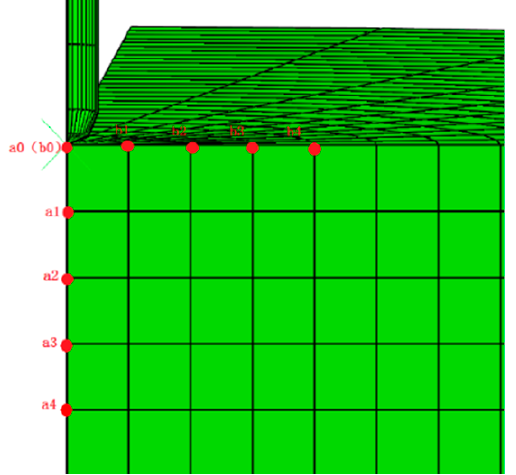
Figure 8. The location of monitoring points.